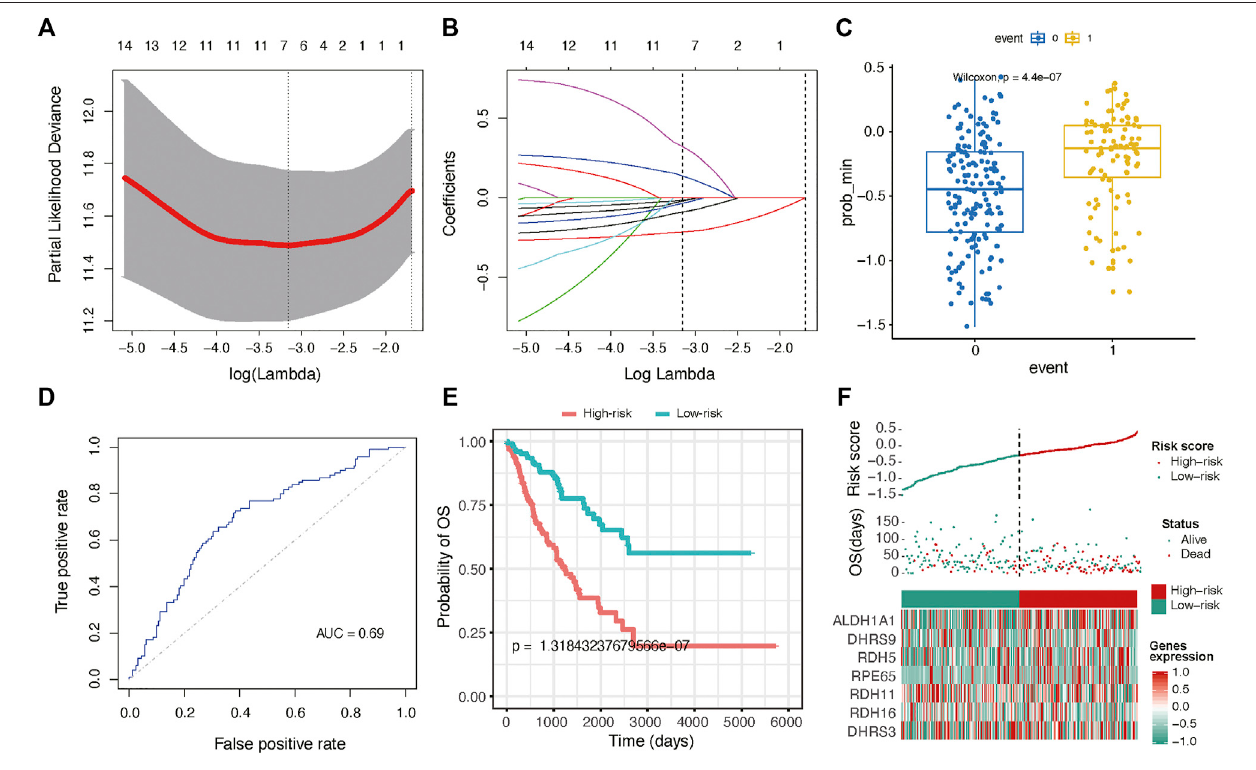
FIGURE 4 | Gene signature with RA metabolism-related enzymes. The regression coef fi cients. (A) calculated by multivariate Cox regression using LASSO (B) are exhibited (C) BoxplotshowstheriskscoredifferencebetweensampleswithdifferentOSstatuses. (D) ROCcurvesshowthepredictiveef fi ciencyoftherisksignature. (E) Kaplan – MeiersurvivalcurvesforpatientsintheTCGAdatasetassignedtohigh-andlow-riskgroupsbasedontheriskscore. (F) RiskplotfortheSARCpatientsinTCGA datasets. Each panel consists of three rows: the top row showed the risk score distribution for the high- and low-risk score group; the middle row represents the SARC patients ’ distribution and survival status; the bottom row shows that the heatmap of seven prognostic metabolism-related enzymes expression.